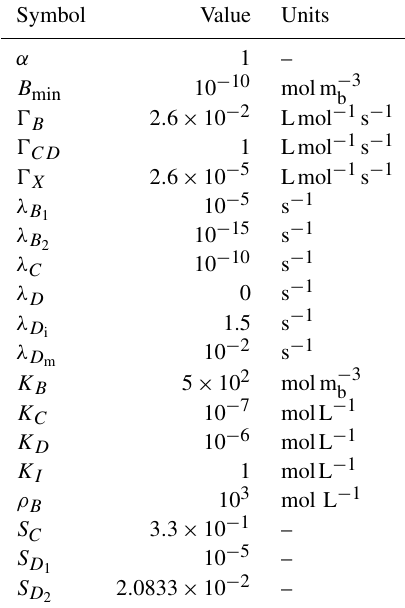
Table 1. CHROTRAN parameter values used in the bio-fouling ex- ample in Sect.